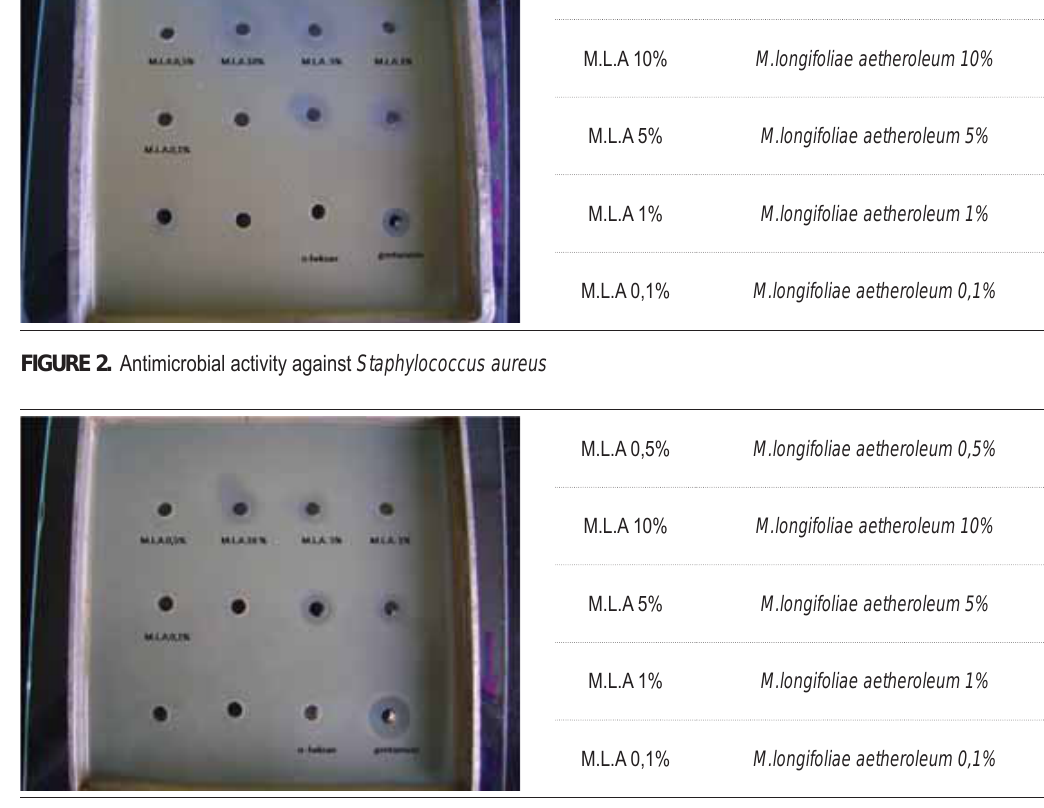
FIGURE 3. Antimicrobial activity against Staphylococcus